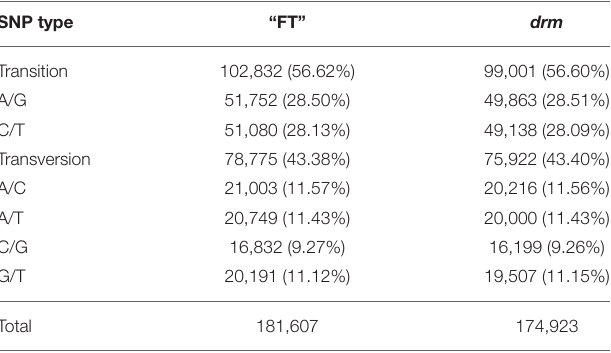
TABLE 4 | Summary of single nucleotide polymorphism (SNP) types identified in drm and